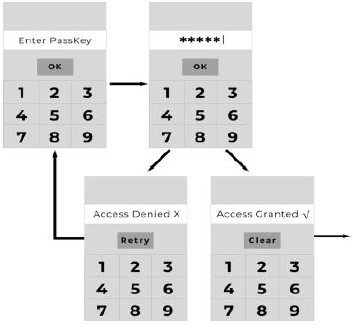
Fig. 8. Wireframes for Android mobile application to be used with lock